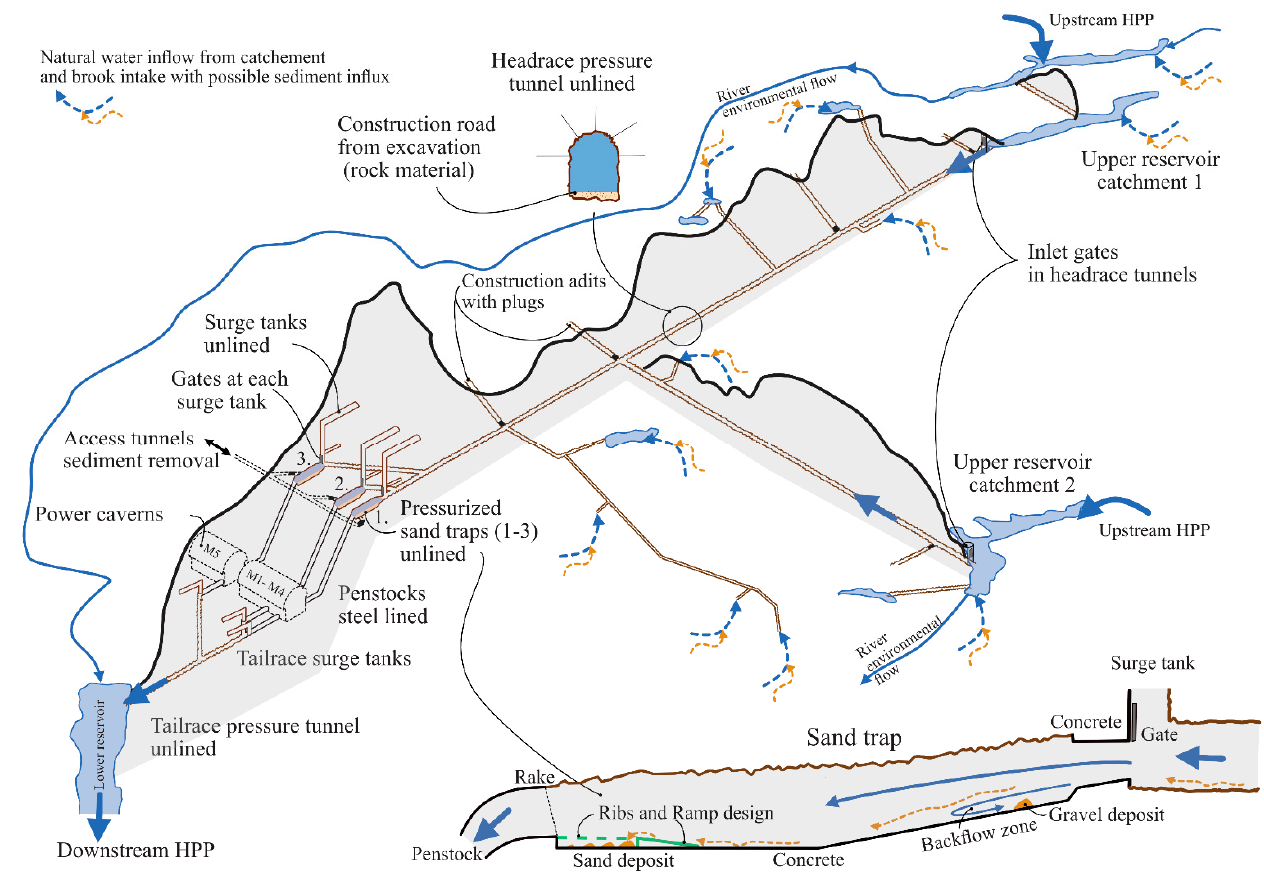
Figure 1. Tonstad hydropower plant and the pressurized sand trap retrofitted with the ribs and ramp design. The total tunnel system exceeds 30 km of unlined tunnels. The figure shows the existing hydropower plant, except the green lines, indicating the proposed retrofitting with the Ribs and Ramp solution. Blue lines indicate water flow, and brown lines indicate sediment flow.